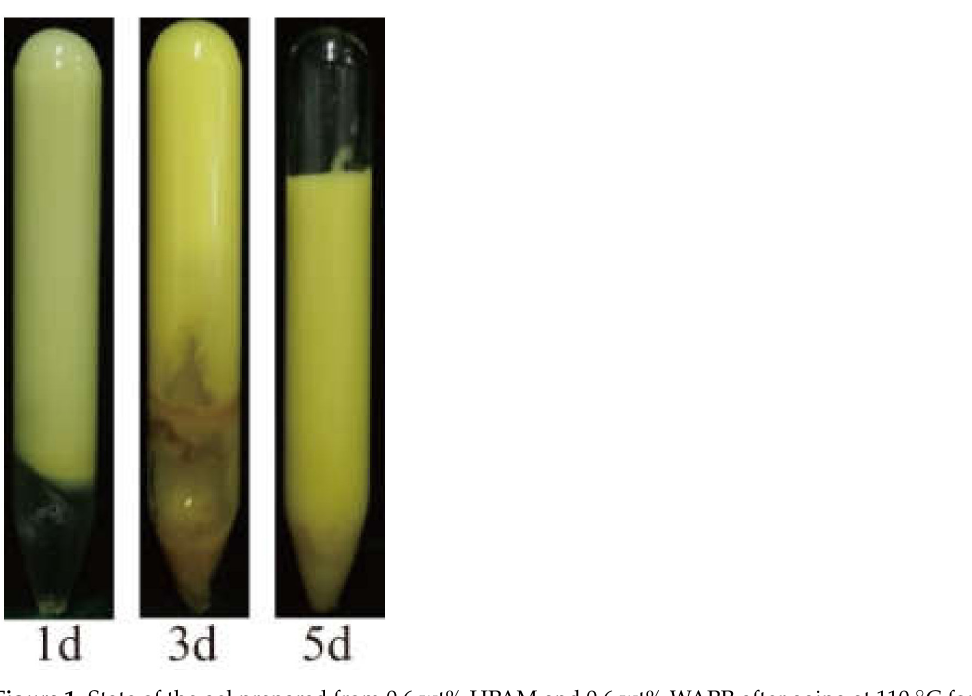
Figure 1. State of the gel prepared from 0.6 wt% HPAM and 0.6 wt% WAPR after aging at 110 ◦ C for 1, 3, and 5 days.